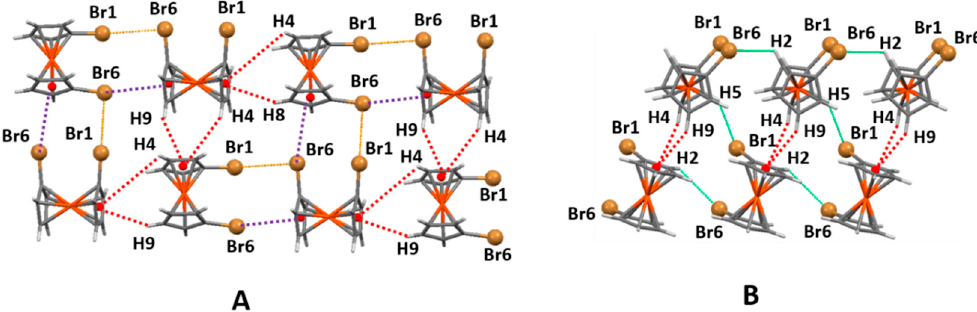
Figure 6. View of supramolecular arrangements of (CpBr) 2 Fe (planes 1,0,1 ( A ), and 0, − 1,1 ( B )).